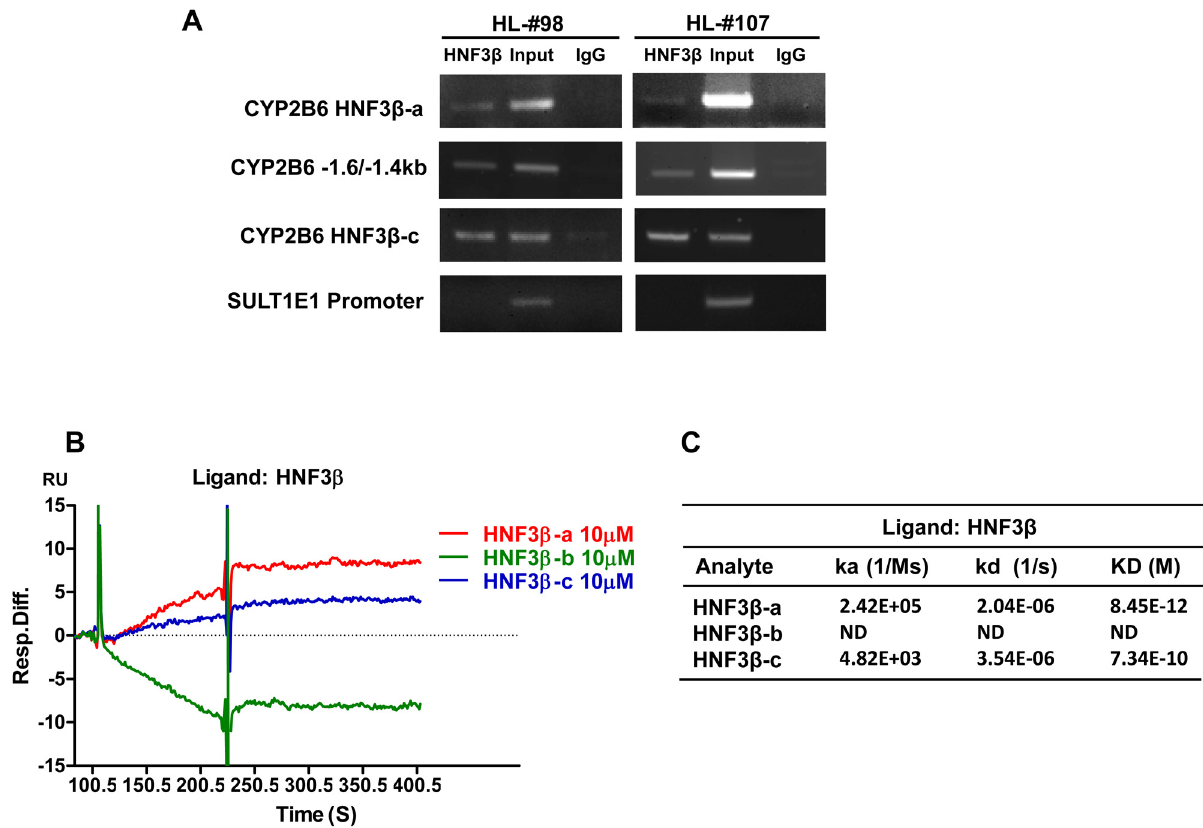
Fig 5. Recruitment of HNF3 β to enhancers identified upstream of CYP2B6 promoter. As detailed in the Materials and Methods , ChIP assays were used to analyze binding of HNF3 β to the HNF3 β -a (distal), HNF3 β -c (proximal) containing, and the -1.6/-1.4kb regions in cultured HPH (A). After precipitation with HNF3 β antibody, de-crosslinked DNA fragments were amplified by PCR. Amplification of the promoter of SULT1E1 was used as negative control as reported previously. In separate experiments, BIACORE SPR affinity assays (B) and (C) were carried out to measure the comparative binding kinetics of CYP2B6 enhancers on HNF3 β as described under Materials and Methods . Sensorgrams of the interaction generated by the instrument were analyzed by the software BIAeval 3.2.